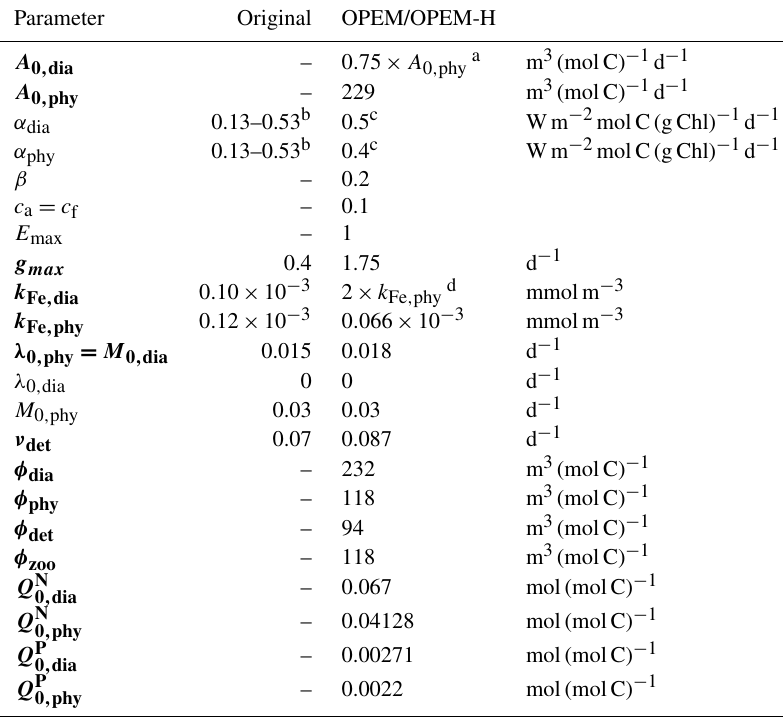
Table 2. Parameter settings for the original and our reference OPEM and OPEM-H configurations. Parameters in bold vary within the ensembles of simulations (Chien et al., 2020). Symbol descriptions are given in Table